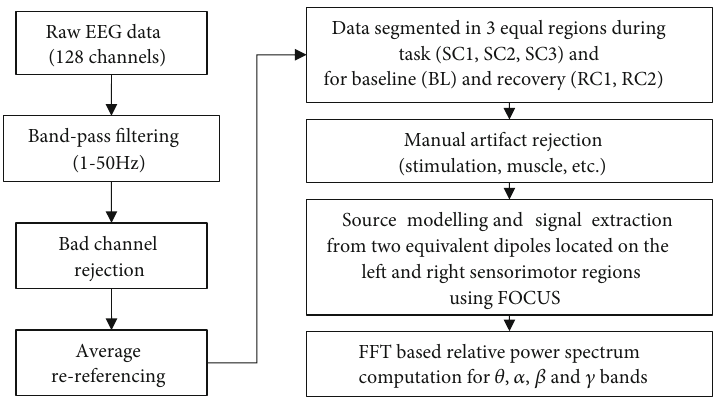
Figure 1: EEG processing